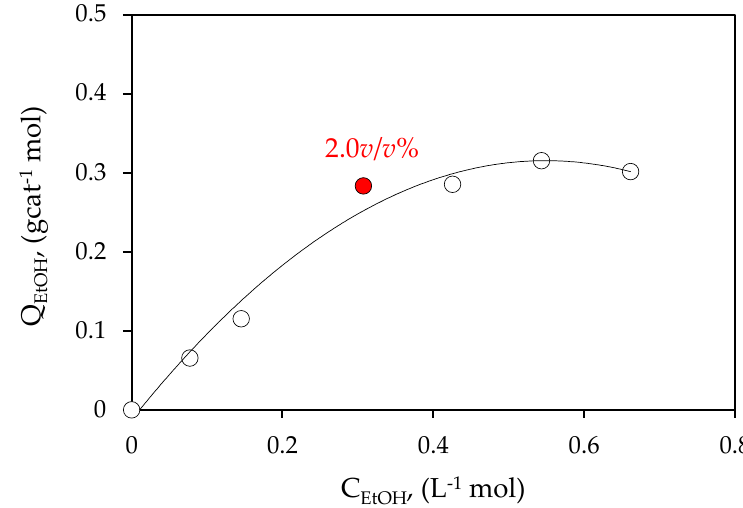
Figure 6. Ethanol adsorbed on 0.25 wt% Pd-TiO 2 photocatalyst.